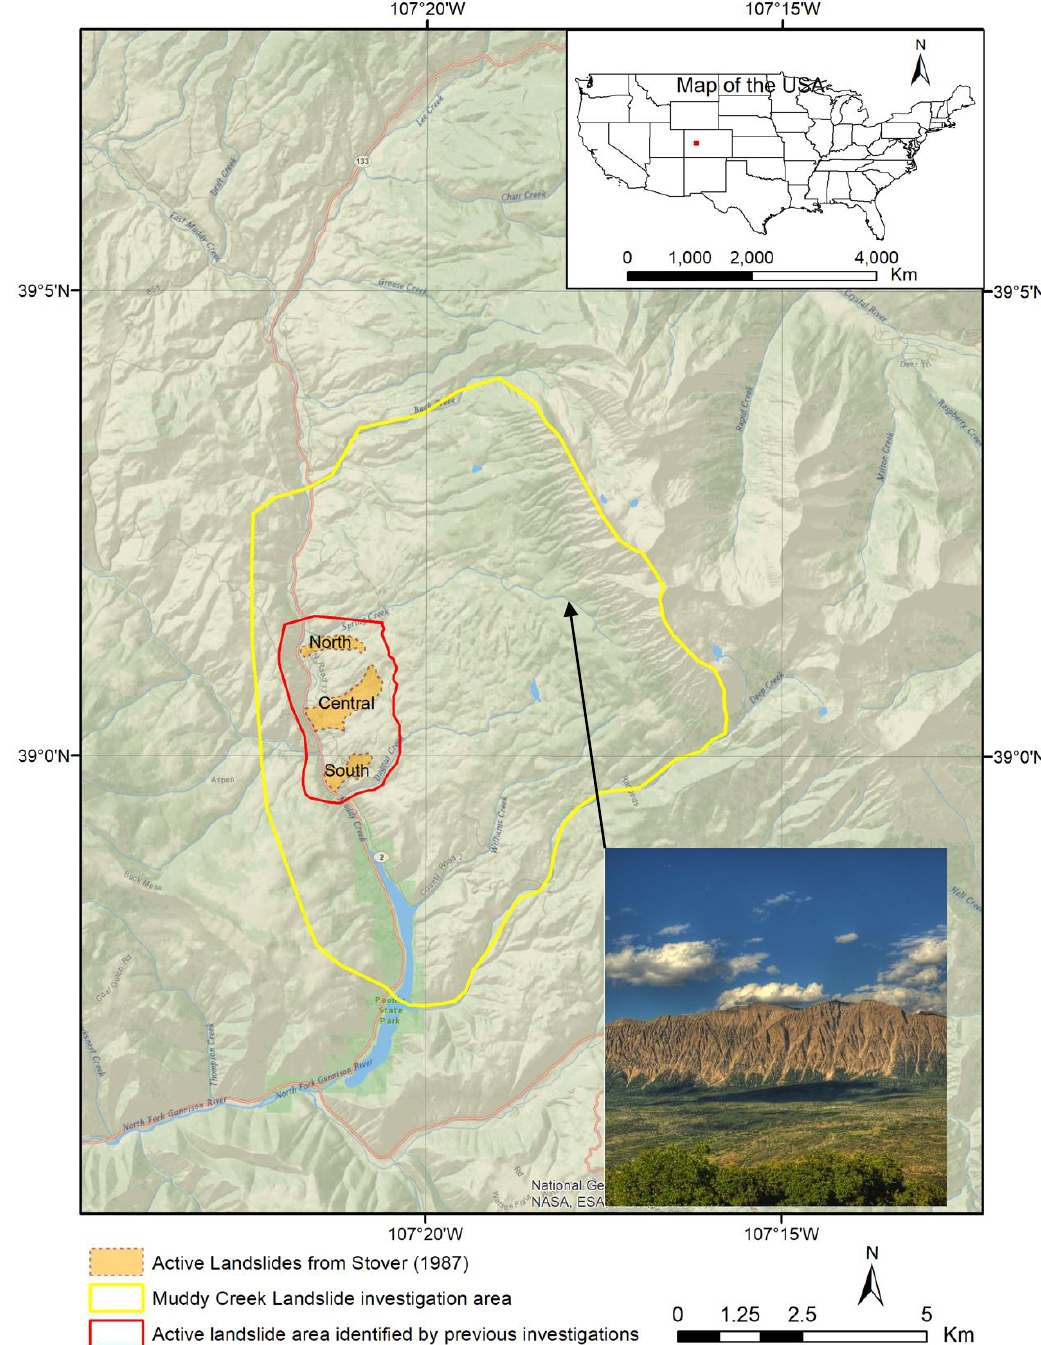
Figure 1. Location of the “East Muddy Creek Landslide Complex” in Gunnison County, Colorado, USA.